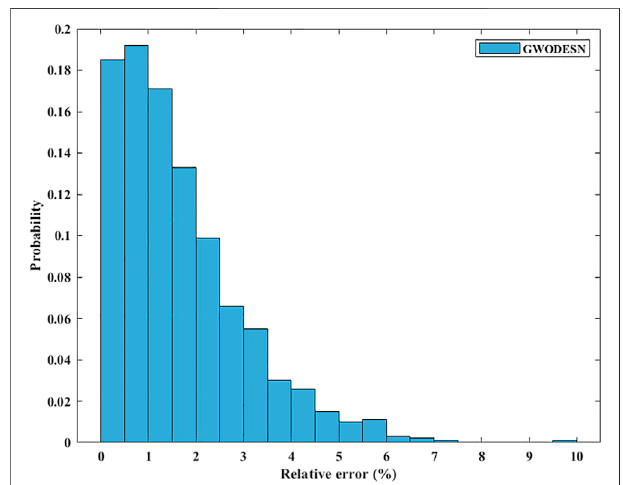
FIGURE 8 | Relative error distribution for